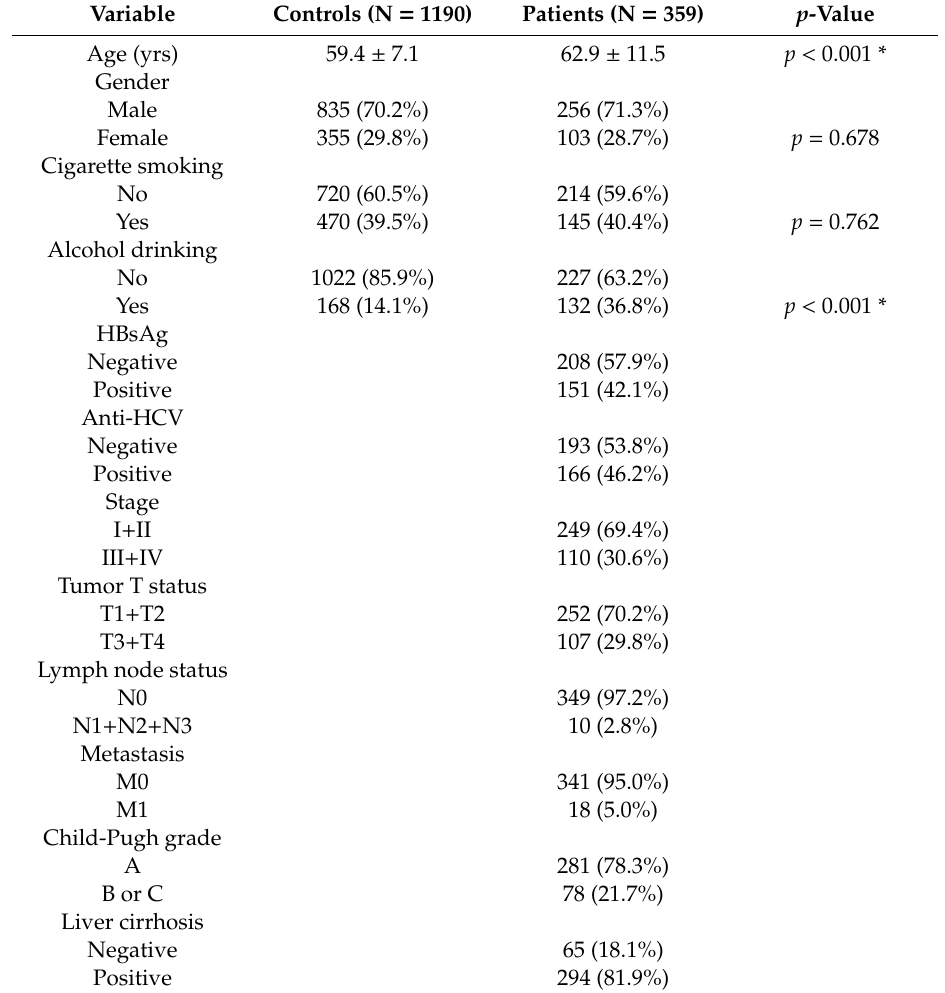
Table 1. The distributions of demographical characteristics in 1190 controls and 359 patients with hepatocellular carcinoma